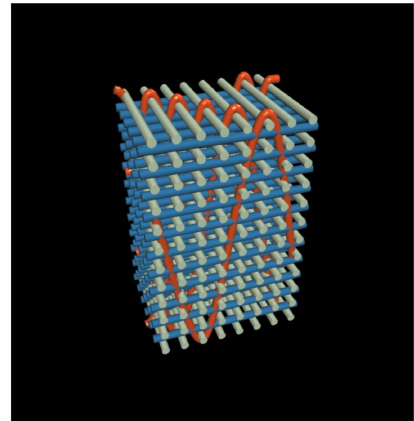
Figure 2. Orthogonal weave